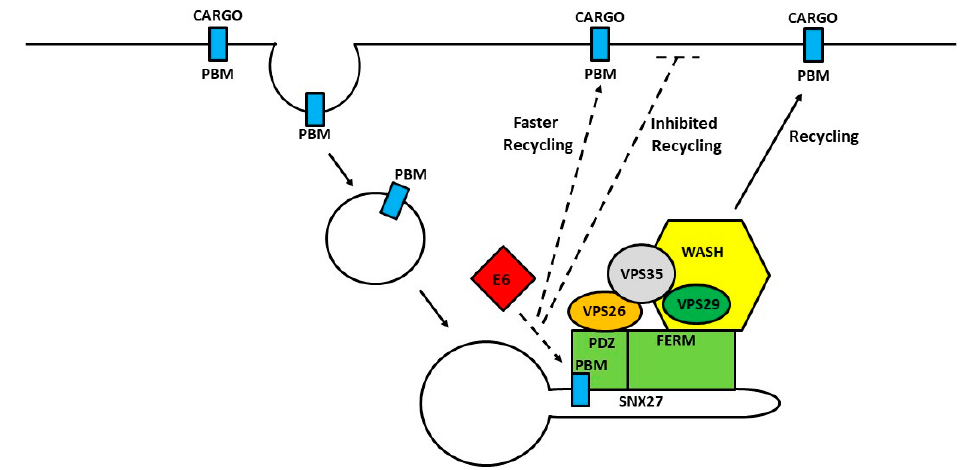
Figure 3. Working model showing the possible mechanism of modulation of SNX27-retromer mediated cargo recycling by HPV E6. After internalization, cargoes containing a PDZ-binding motif (PBM) bind to a PDZ domain of SNX27. SNX27 serves as an adaptor linking its cargoes to the endosomal tubules through its interaction. Association within the SNX27-retromer-WASH complex directs the cargoes towards recycling to the plasma membrane. The E6-SNX27 interaction may be a transient step in the handover in the SNX27-retromer complex for cargo binding, which may in turn promote faster recycling or inhibit recycling of certain PBM-containing cargoes. It is still unknown if E6 helps recruit SNX27 to certain endocytic compartments or competes for binding with SNX27 cargoes. Solid line shows the role of the SNX27-retromer complex in cargo recycling. The dashed line shows how E6 might affect this.